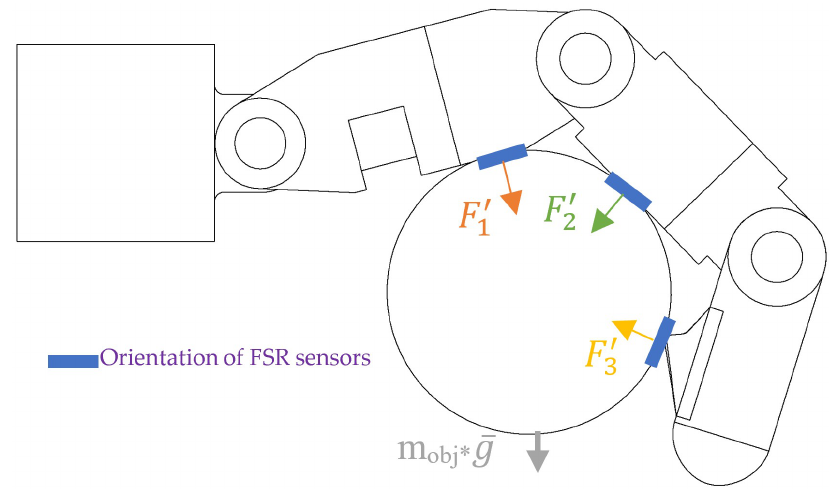
Figure 5. Forces acting on grasped object.